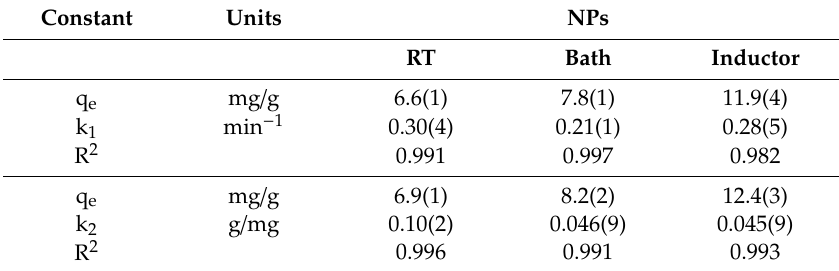
Table1. KineticconstantsofNPsperformedunderthreedifferentexperimentalconditions(roomtemperature (RT), bath immersion, and inductor heating) at 2 g / L sorbent concentration. Table 1. Kinetic constants of NPs performed under three different experimental conditions (room temperature (RT), bath immersion, and inductor heating) at 2 g/L sorbent concentration.